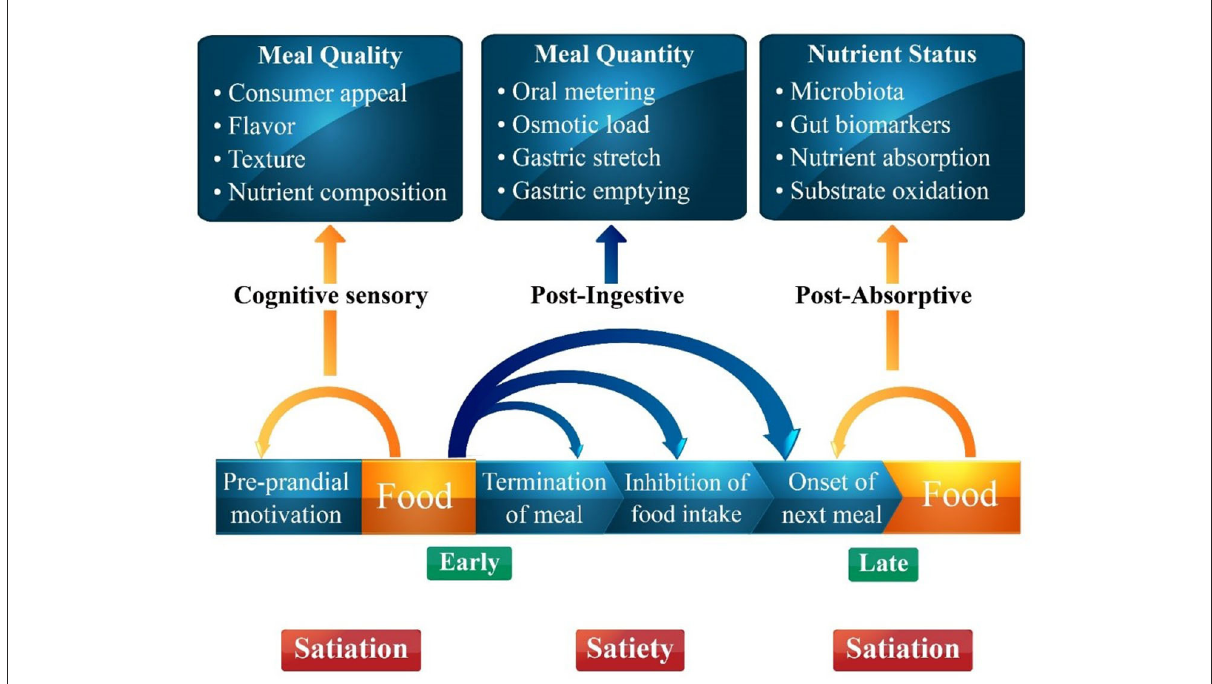
FIGURE1 A schematic figure of the different components of the food before and after food intake determining satiation and satiety adapted from the satiety cascade model of Blundell and